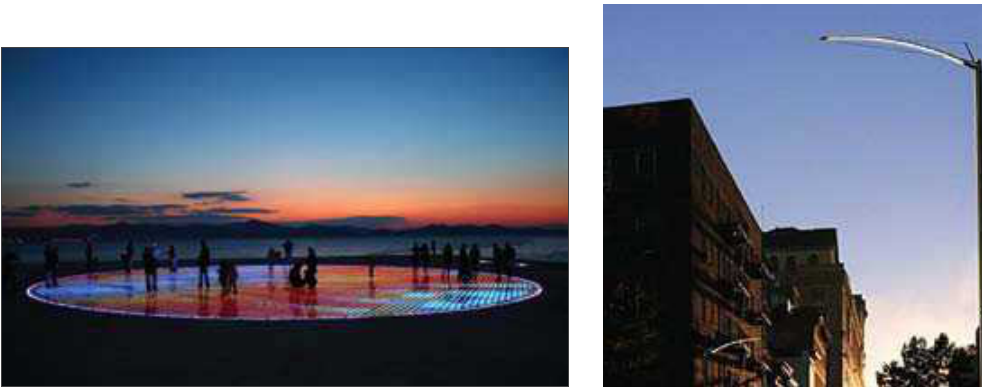
Fig. 20. “Greeting to the Sun” by Zadar, croatia, 2009